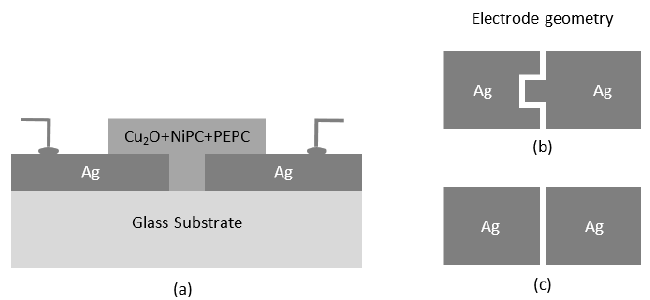
Figure 2. ( a ) Cross-sectional view of organic-inorganic hybrid composite based humidity sensor; top view of ( b ) interdigitated and ( c ) rectangular electrodes configuration.